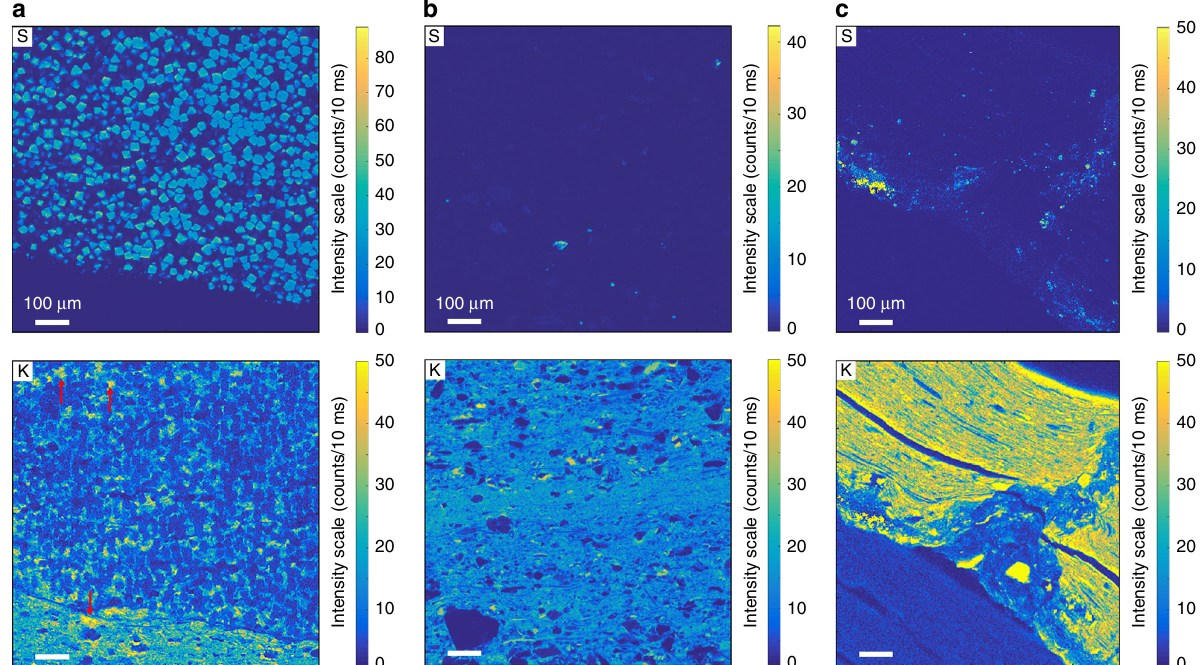
Fig. 4 High-resolution sulfur and potassium distribution maps. a Pyritized MRS. Red arrows point to K enrichment between pyrite crystals and in the host sediment of MRS. b Black shales. c Non-pyritized MRS. Higher X-ray fl uorescence (XRF) intensities correspond to higher S and K contents. For